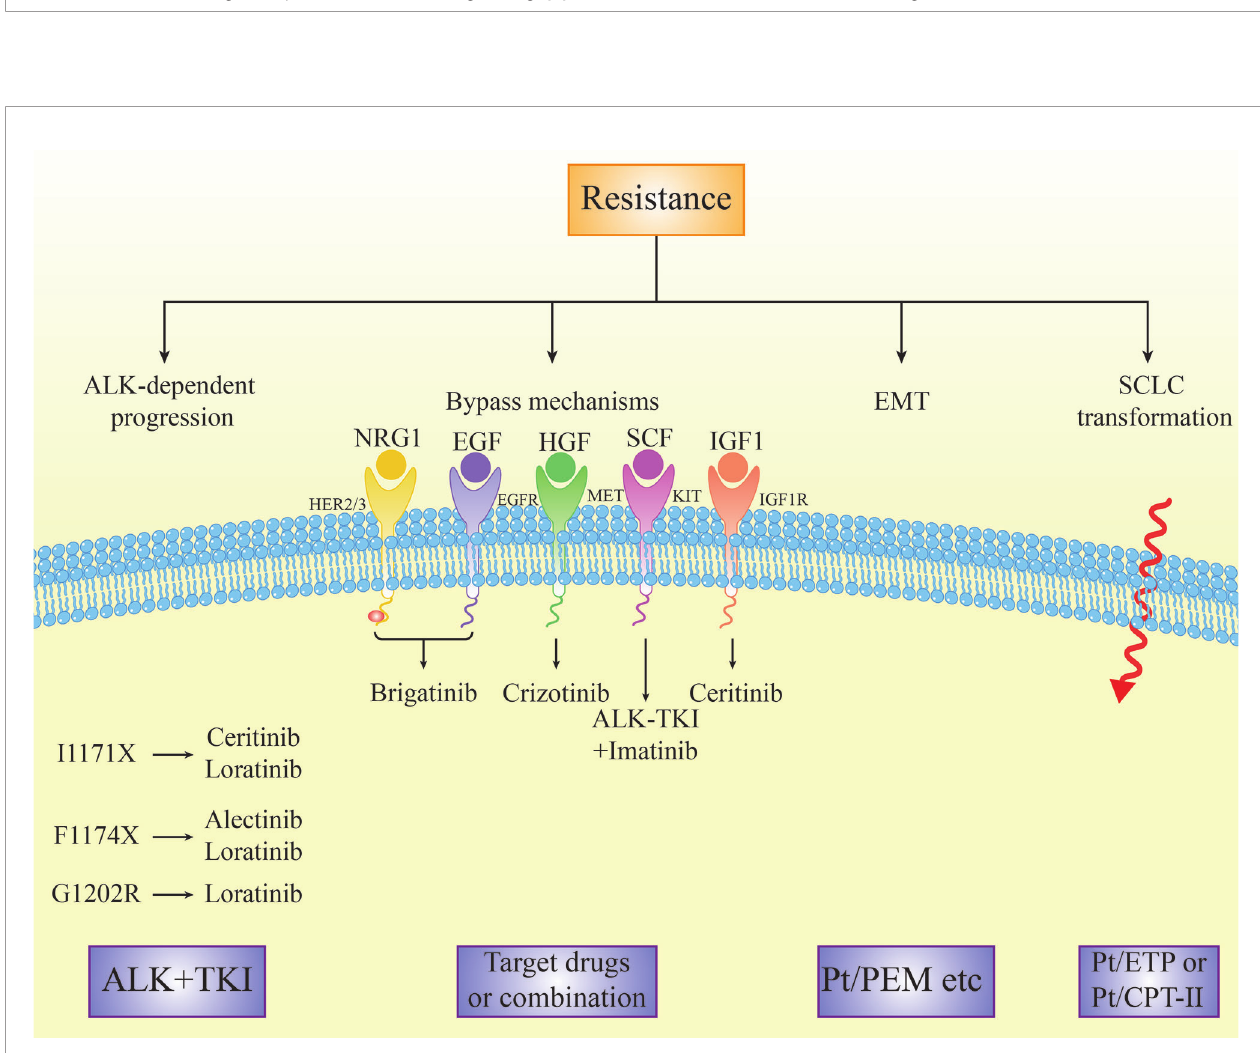
FIGURE 4 | The resistance mechanisms of ALK TKIs in advanced NSCLC and next treatment